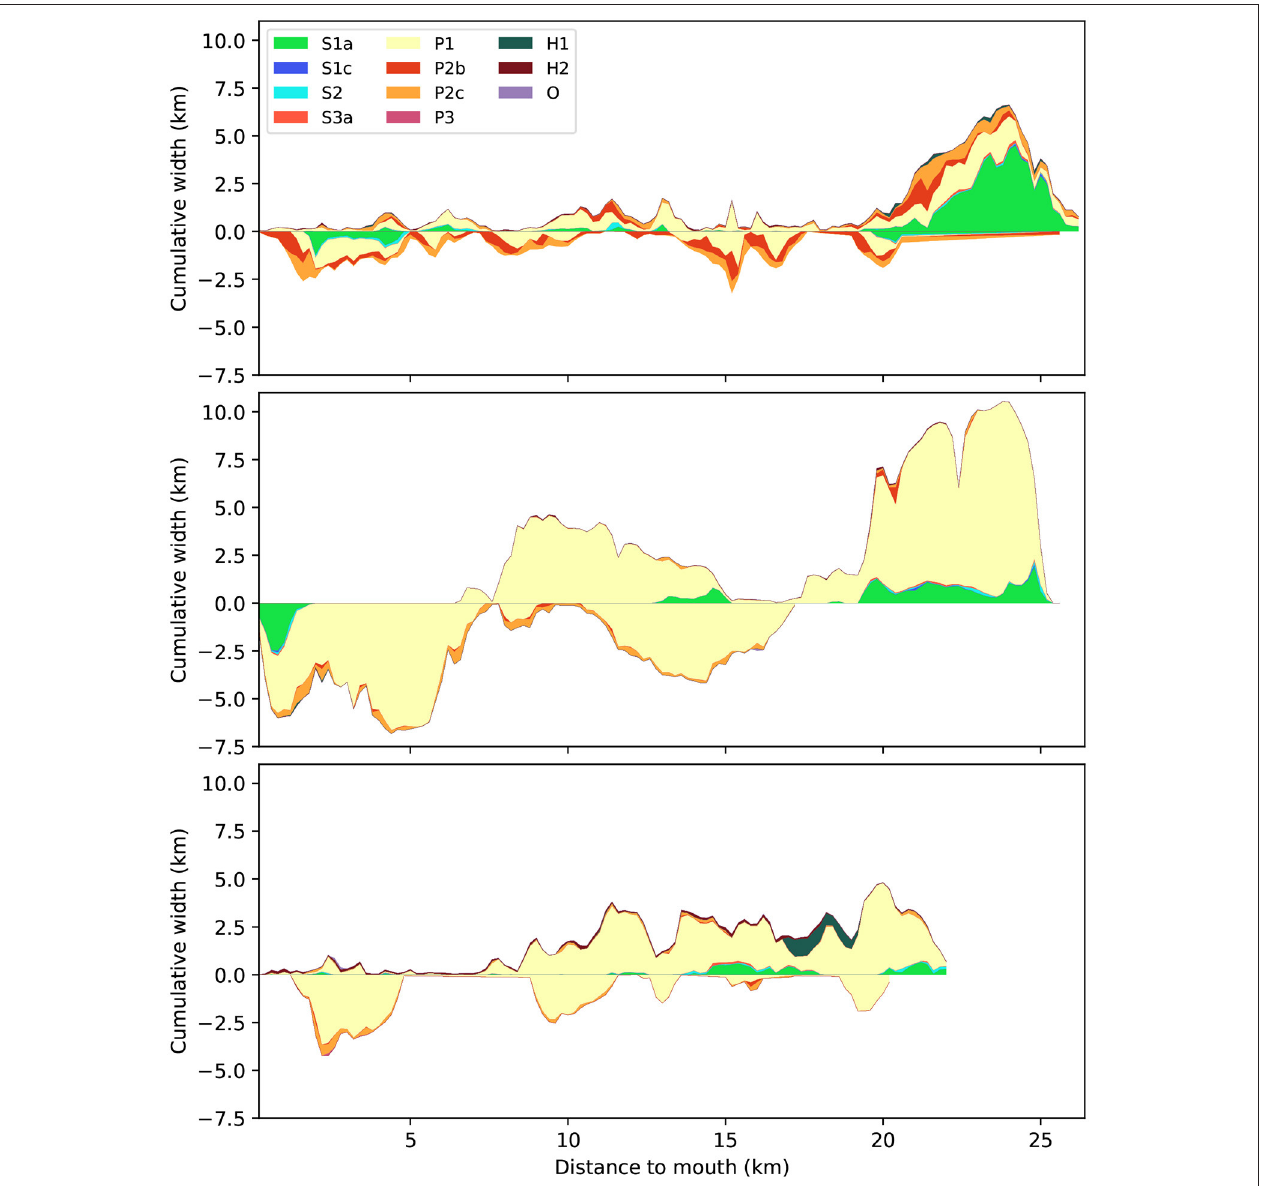
FIGURE 7 | Distribution of biogeomorphological classes separated for shore-connected and mid-channel areas as absolute width along the Western Scheldt (top) , Eems-Dollard (middle) , and Eastern Scheldt (bottom) . Positive widths refer to shore-connected tidal flats and saltmarsh and negative widths refer to the bars and shoals. Distance is measured along a centerline from the narrowest cross-section in the seaward mouth. For explanation of legend see Table 2